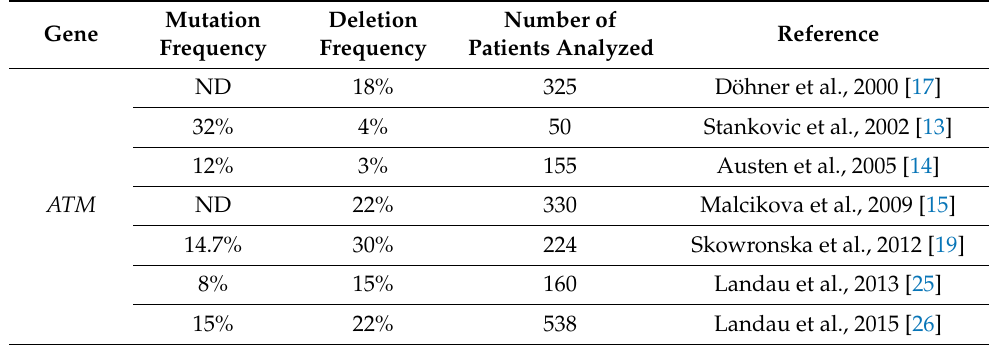
Table 1. Frequency of different p53 pathway alterations in patients with chronic lymphocytic